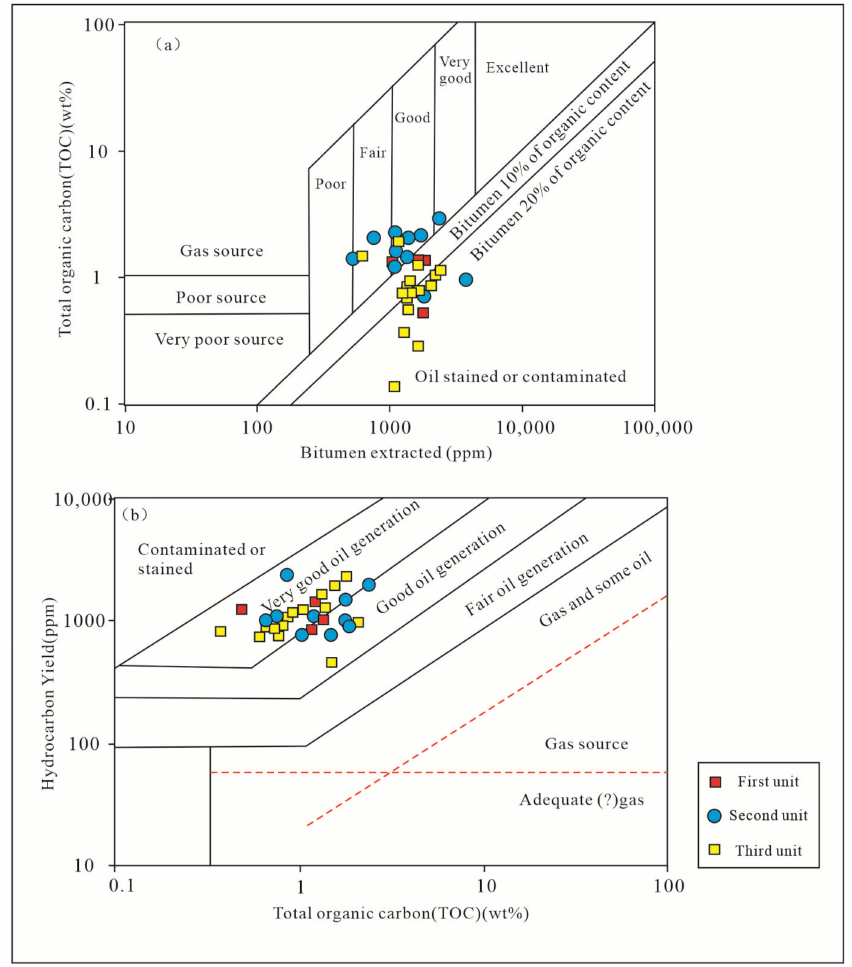
Figure 18. ( a ) Plots of TOC versus bitumen extract showing source potential rating and ( b ) plots of TOC versus hydrocarbon yield, adapted from